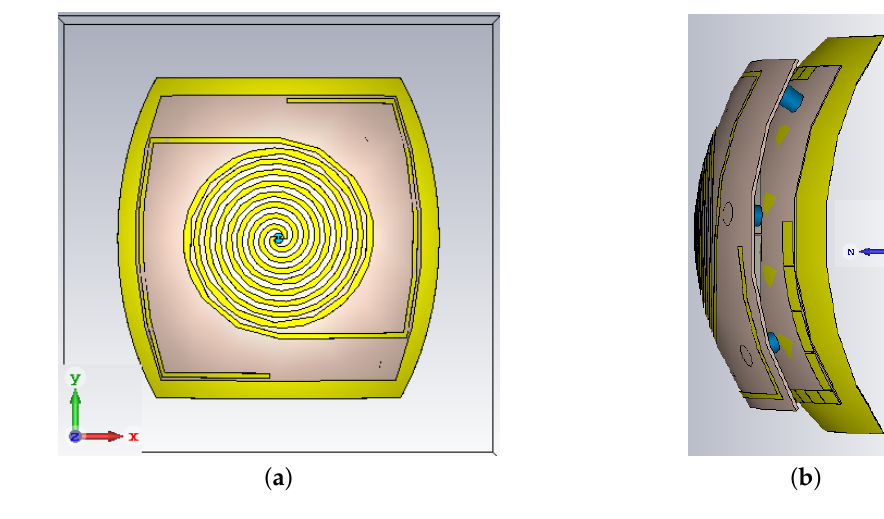
Figure 12. Conformal antenna design ( a ) Top view ( b ) side